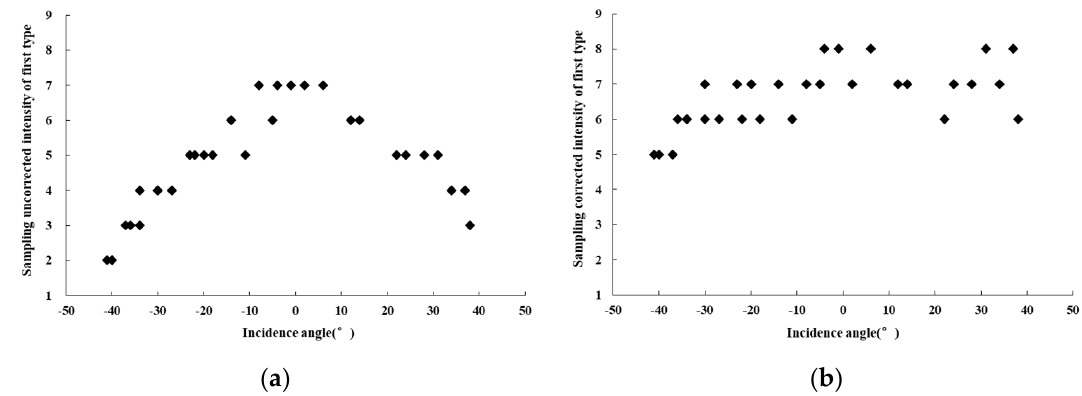
Figure 10. Results for strip 2: ( a ) the original intensity values (the amplitude); ( b ) the corrected intensity values by eliminating the effects of incident angle and range.